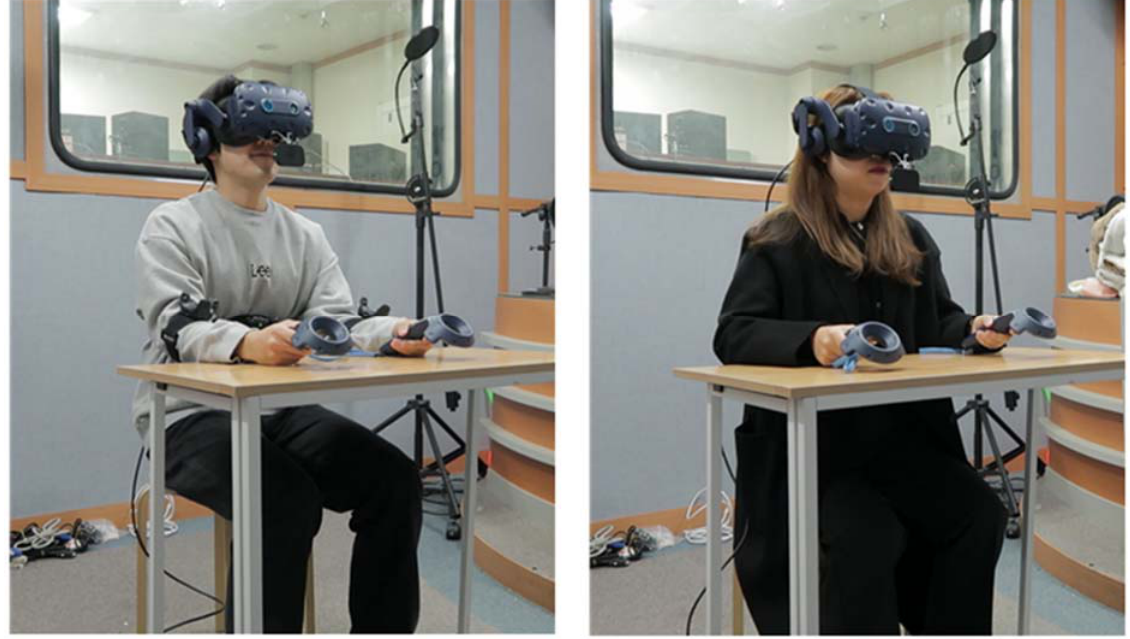
Figure 2. Two participants wearing the equipment for the experimental VR content.